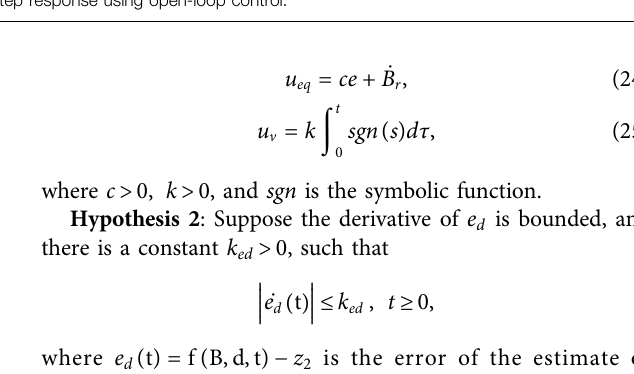
FIGURE 12 | Open-loop control response of different high-frequency and low-frequency input signals that uses the J – A model. (A) Window function response using open-loop control. (B) Multistep response using open-loop control. (C) Step response using open-loop control.